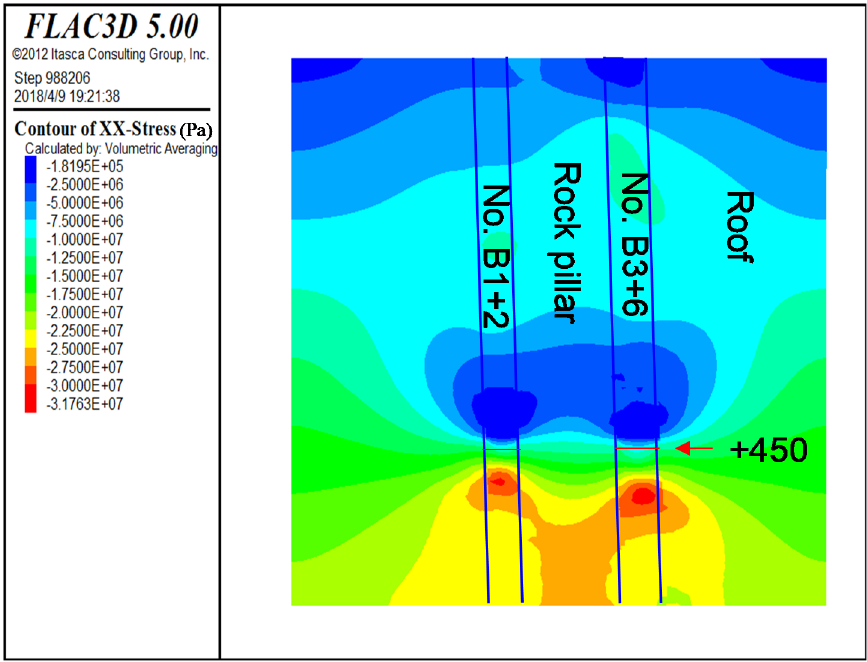
Figure 13. Horizontal stress distribution around the coal seam and rock mass.